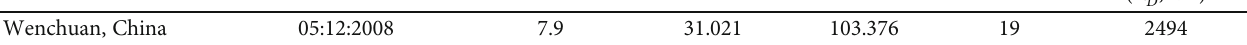
Table 3: Epicentral parameters of the Wenchuan earthquake, China. Earthquake (case study)